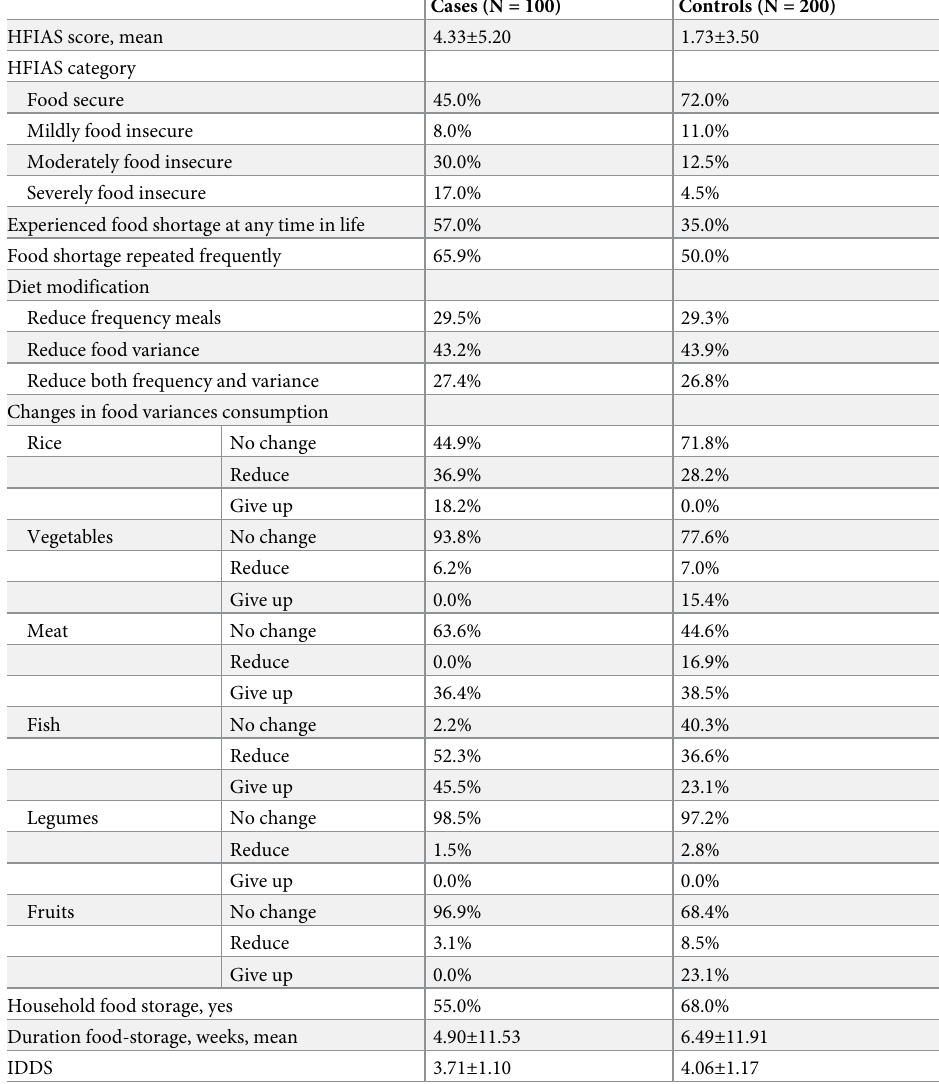
Table 2. Food insecurity, food shortage, diet modifications, food storage, and dietary